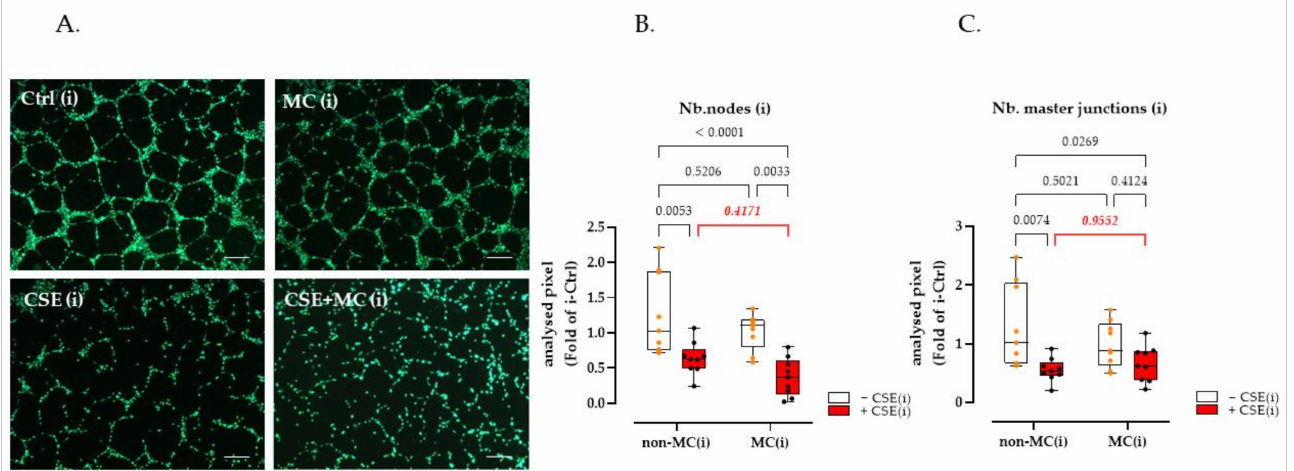
Figure 5. Inhibition of Akt phosphorylation inhibited the therapeutic effect of 100 µ A MC to enhance CSE-injured angiogenesis. ( A ) Effect on HUVEC tube formation with fluorescent calcein-AM (2 µ M, green) staining of formed tubes, scales bars indicate 200 µ m length, “i” indicates that the supernatant used for the experiment was collected from SC394003 (inhibitor) pretreated HaCaT cells. ( B , C ) The number of nodes and number of master junctions (as x-fold of Ctrl (i)). N = 3, n = 3. Non-parametric two-way ANOVA followed by Tukey’s multiple comparison test was performed to compare the